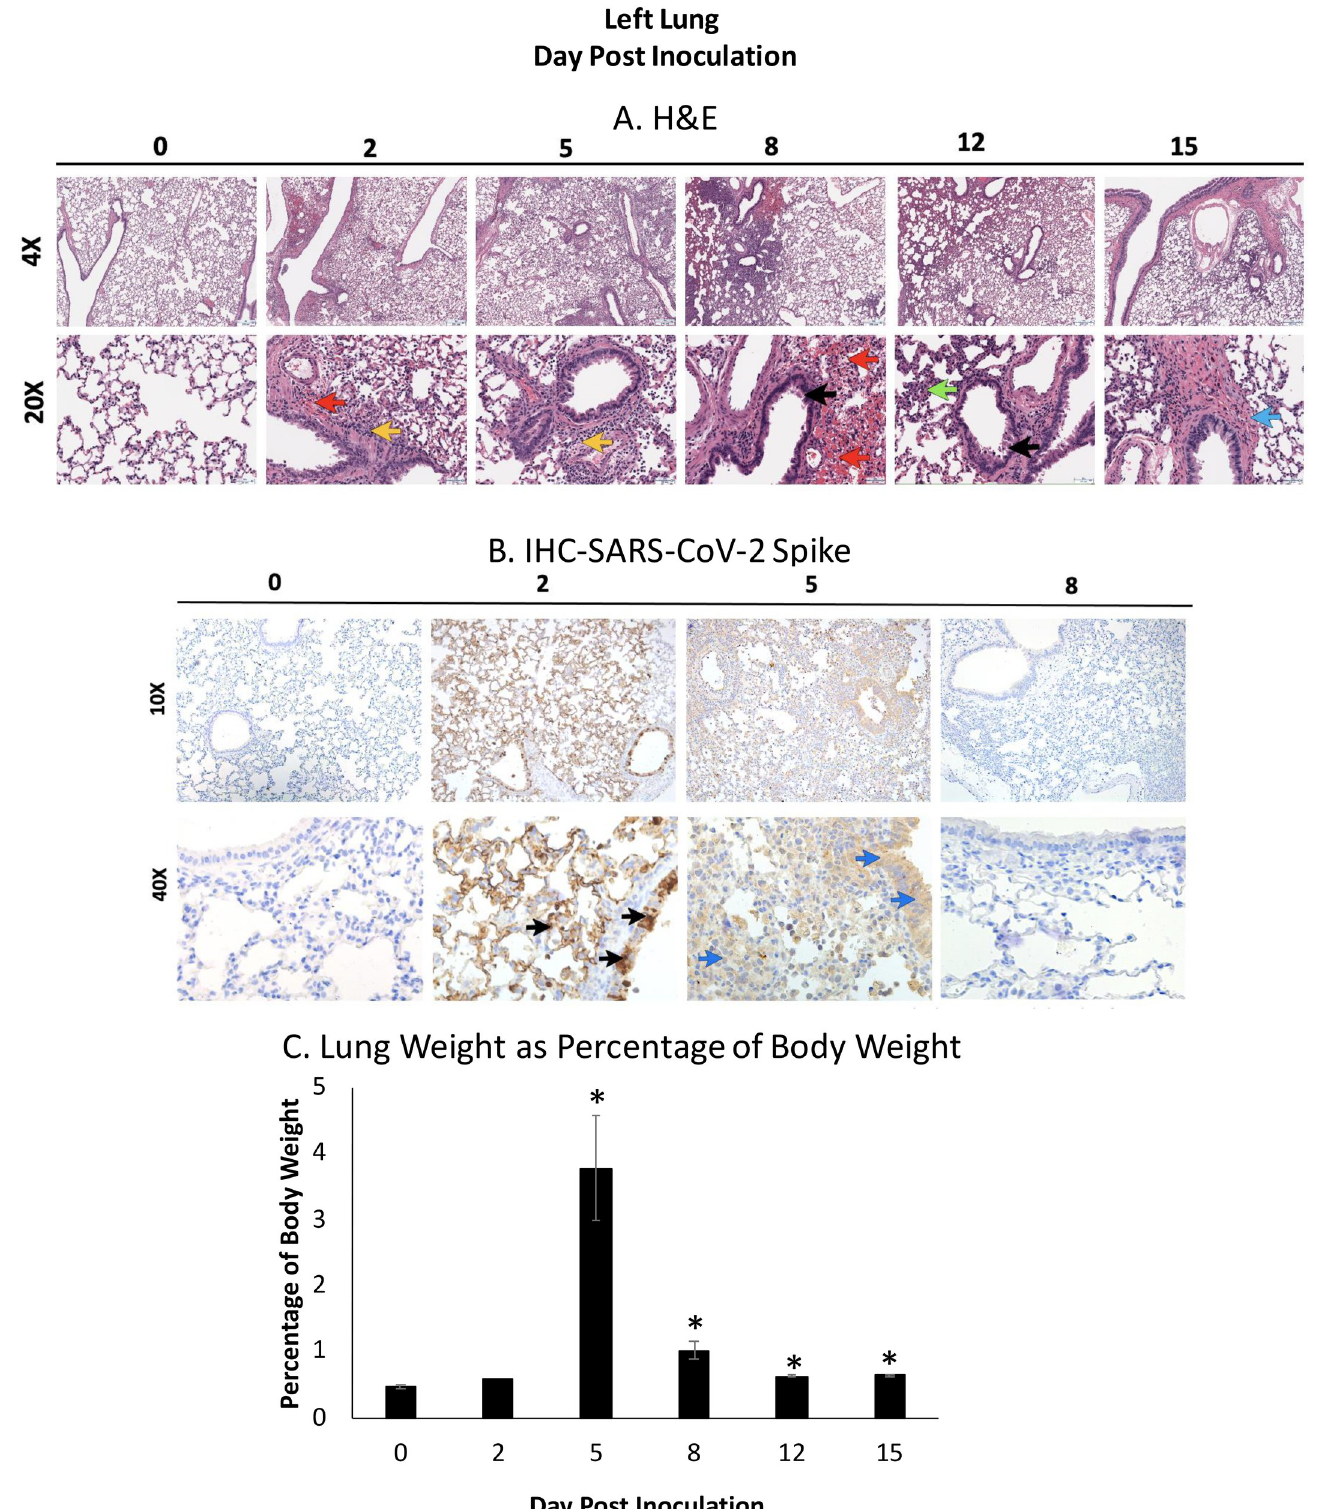
Fig 4. Inoculated hamsters have significant inflammation in the lung coinciding with SARS-CoV-2 Spike antigen staining. The left lung was collected from each animal at necropsy and perfused with 10% formalin prior to paraffin block embedding and H&E staining. Red arrows indicate hemorrhage; green arrows